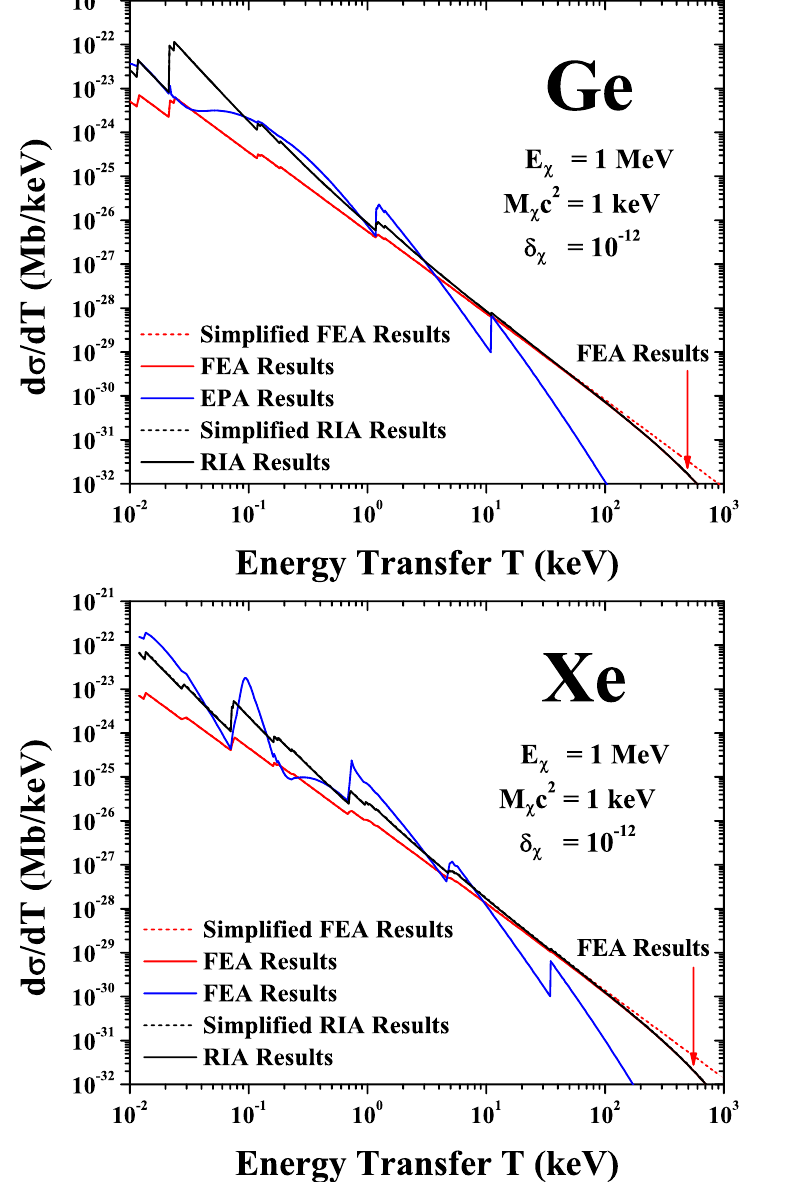
Figure 4 . Differential cross sections of atomic ionization process for Ge and Xe atoms induced by millicharged dark matter particles. The mass and initial energy of millicharged particle are chosen as m = 1 MeV, and the dark matter particle millicharge is chosen 2 = 1 keV and E χ c χ to be δ = 10 − 12 . In this figure, we compare the numerical results on differential cross section χ dσ/dT calculated in the FEA, EPA and RIA approaches. The red solid lines correspond to the FEA results calculated through eq. (A.3); red dashed lines represent the simplified FEA results calculated through eq. (A.4); blue lines stand for the EPA results calculated from eq. (B.7); black solid lines show the RIA results calculated using eq. (4.22); and black dashed lines present the simplified RIA results calculated using eq.